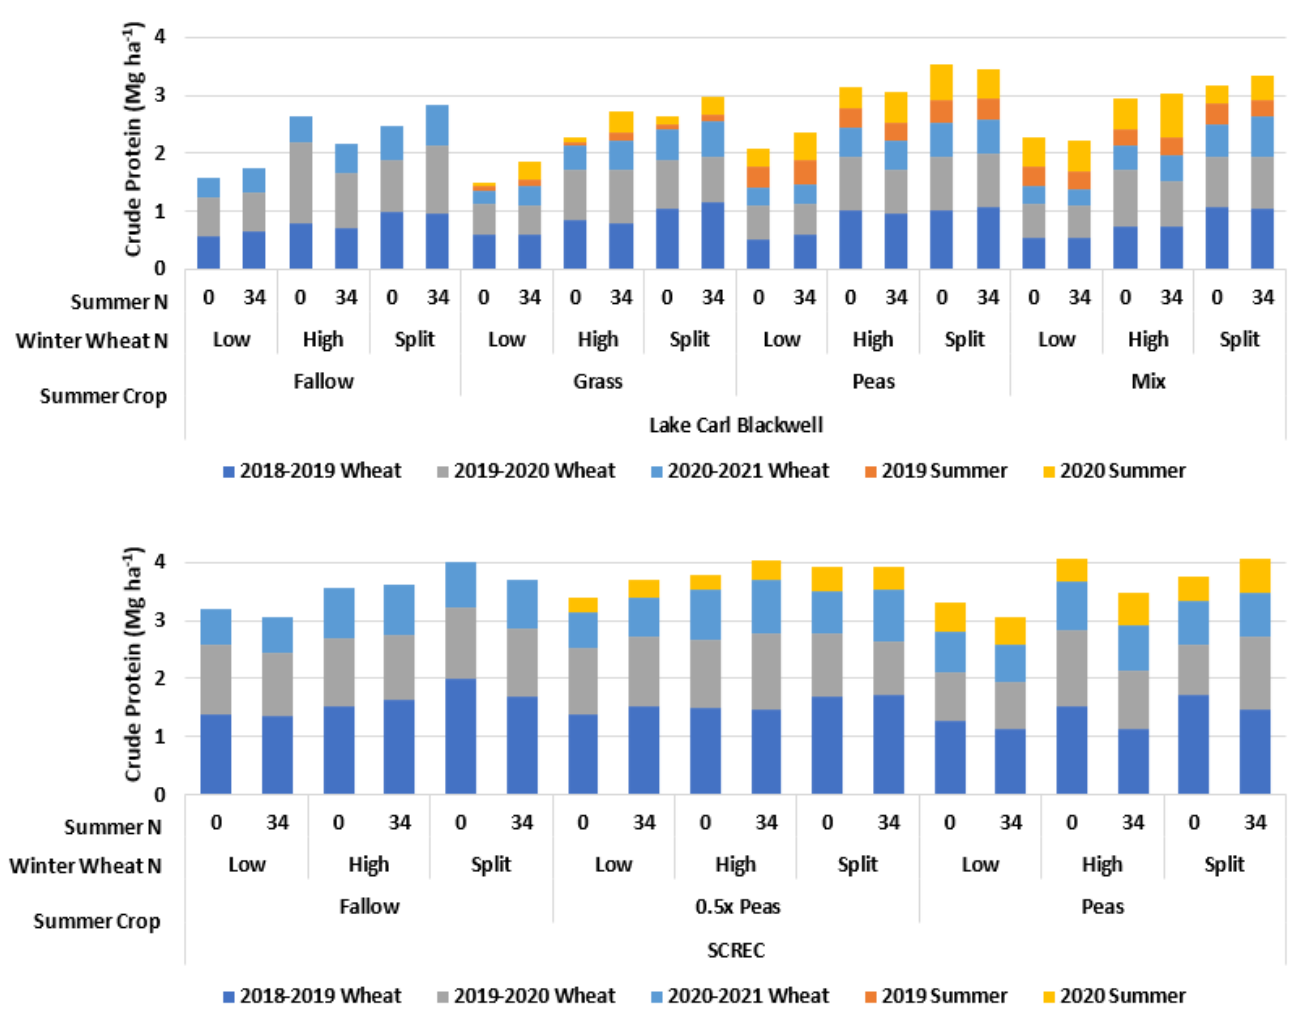
Figure 2. Average crude protein yield (Mg ha − 1 ) as crude protein multiplied by biomass production from each season of production for LCB (Top) and SCREC (Bottom). Means are presented for each of the summer N application rates (kg N ha − 1 ) within each of the summer crop species: fallow, cowpeas (Peas), crabgrass (Grass), cowpea-crabgrass mixture (Mix), and half-planted rate of Cowpeas (0.5× Peas), within each of the winter wheat N applications Low (67 kg N ha − 1 pre-plant), High (135